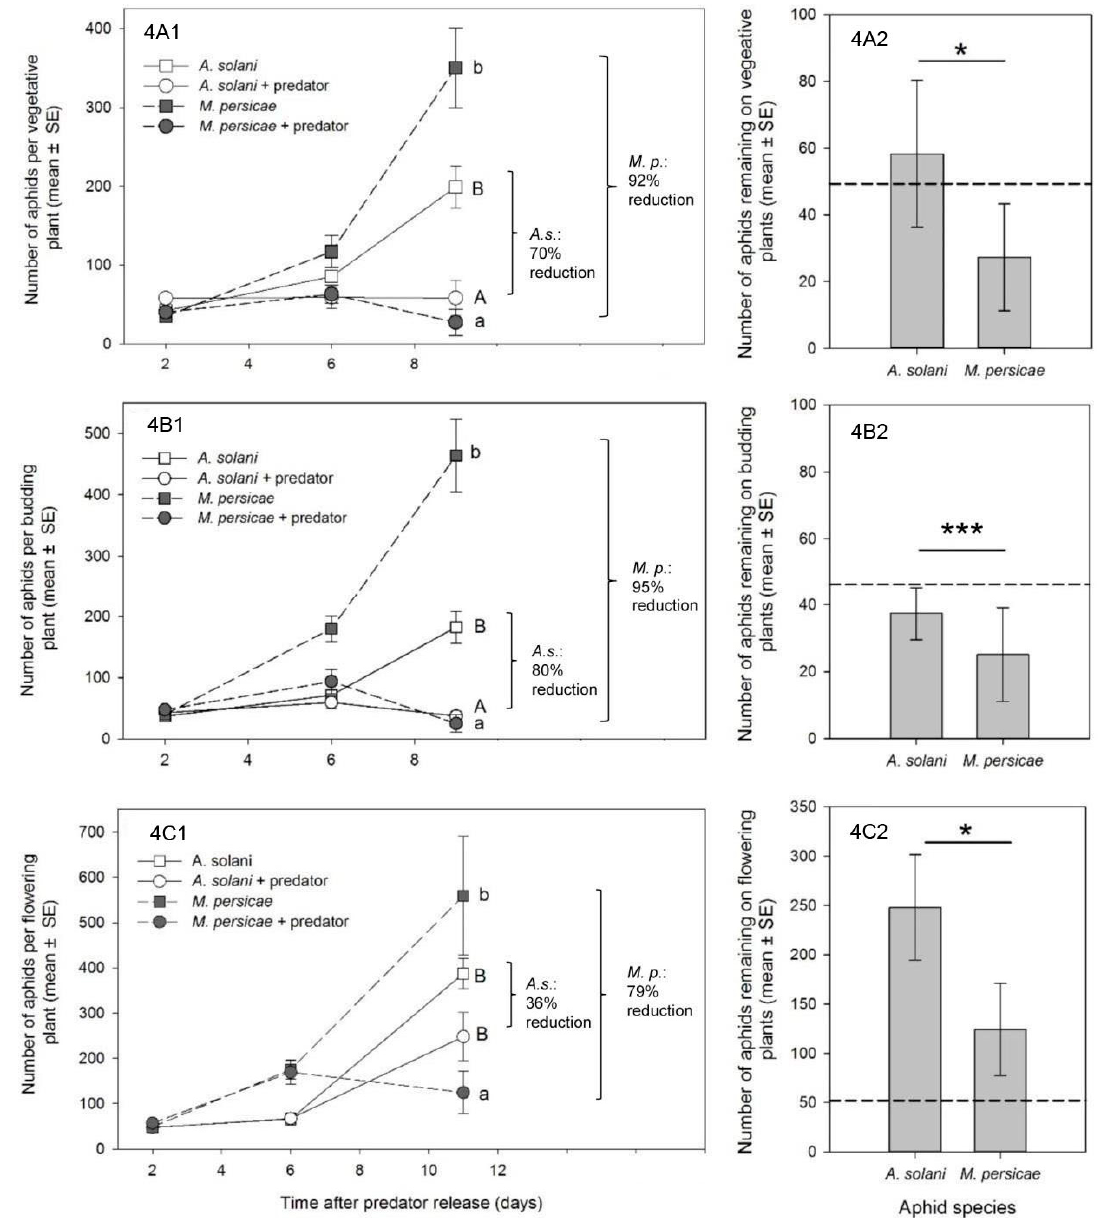
Figure 4. Plants were in the following stages of growth: ( A ) vegetative; ( B ) budding; ( C ) flowering. ( A1,B1,C1 ) Mean aphid density ± SE of A. solani ( A.s. ) or M. persicae -infested ( M.p .) plants with no control measure (square symbols) or with releases of Aphidoletes aphidimyza (circle symbols). Different letters represent significant differences from comparisons made within each aphid species. Percent control of each aphid species is also presented; ( A2,B2,C2 ) Comparison between aphid species on predator-treated plants at the end of the experiments (means and SE presented). The dashed line represents the level of aphid infestation at the start of the experiment. A “*” symbol indicates weak significance ( p ≤ 0.08); “***” indicates high significance ( p ≤ 0.001). Statistical tests were conducted on log-transformed data, though arithmetic means and SEs are shown.